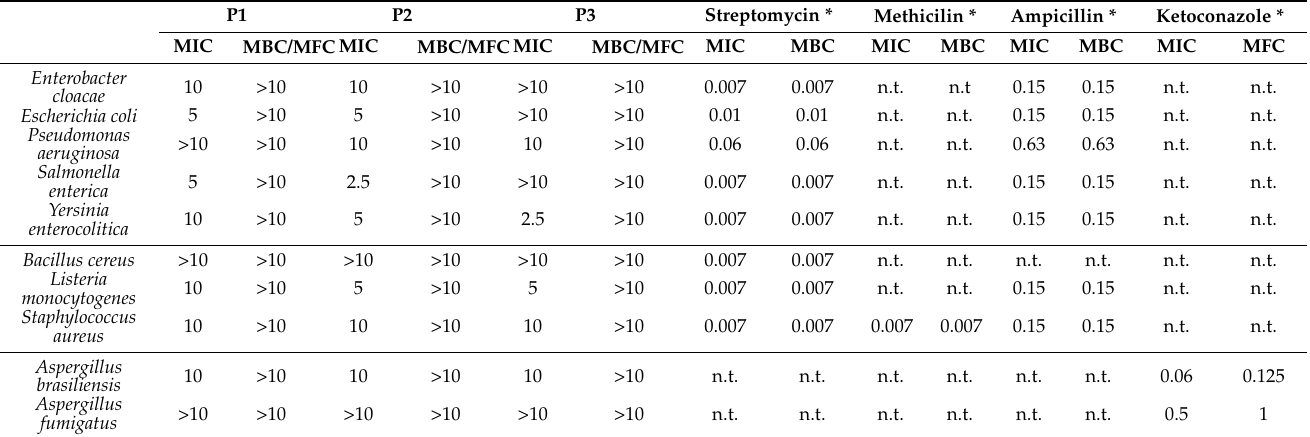
Table 14. Antimicrobial activity under the optimal conditions for each extract